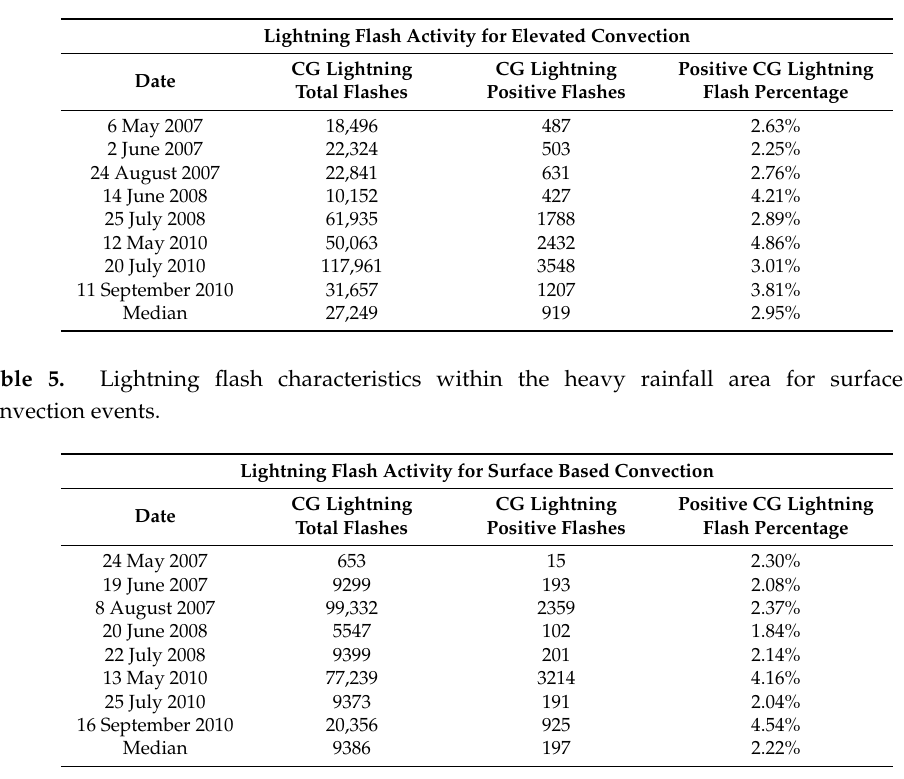
Table 4. Lightning flash characteristics within the heavy rainfall area for elevated convection events.